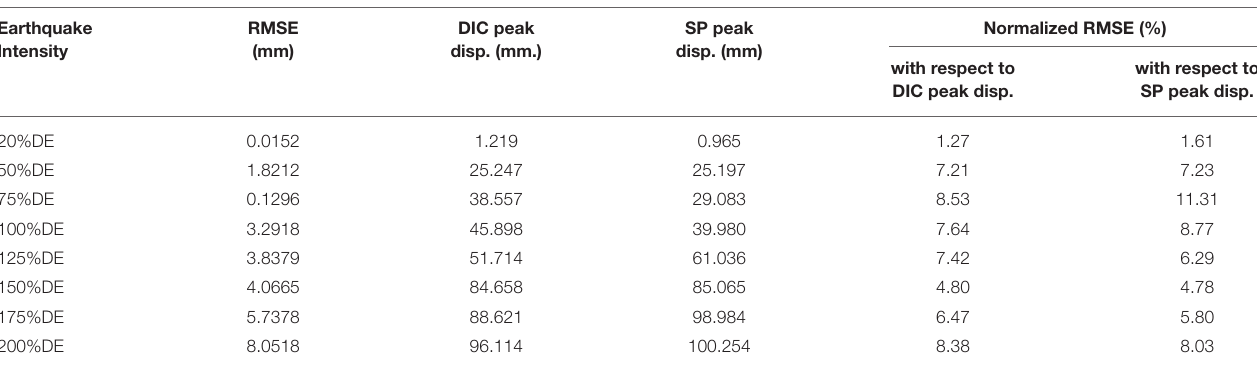
TABLE 3 | Measurement error between target-tracking DIC and SP. Earthquake Intensity